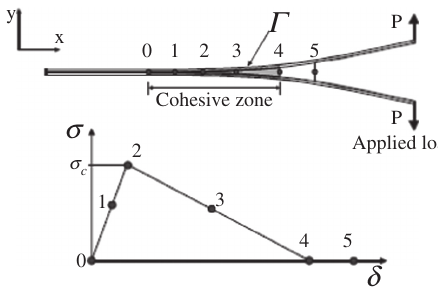
Figure 2 Cohesive zone ahead of delamination